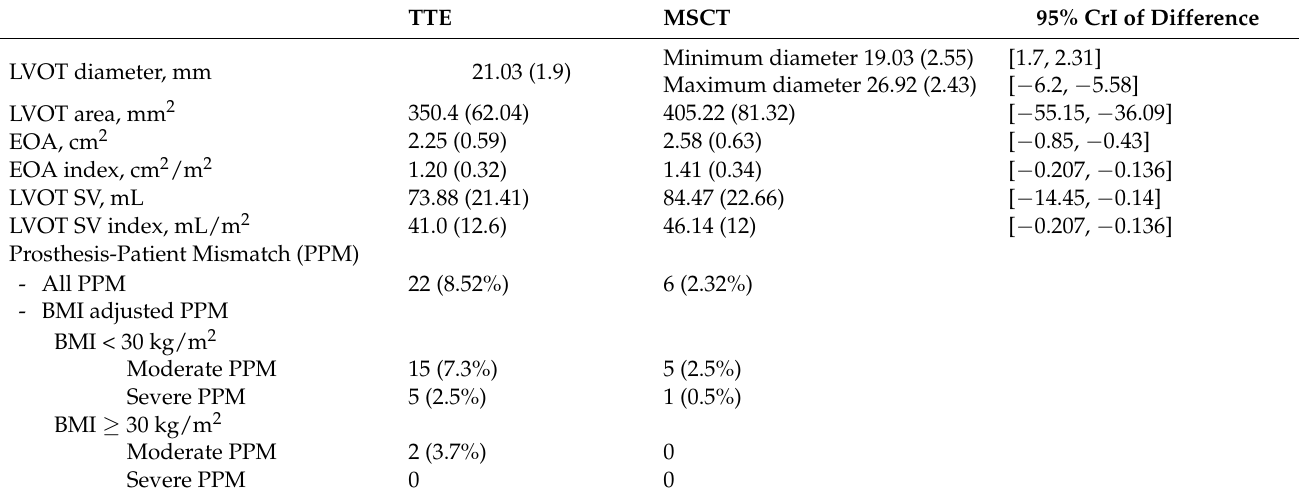
Table 4. LVOT-dependent hemodynamic parameters (TTE- vs. MDCT-derived LVOT